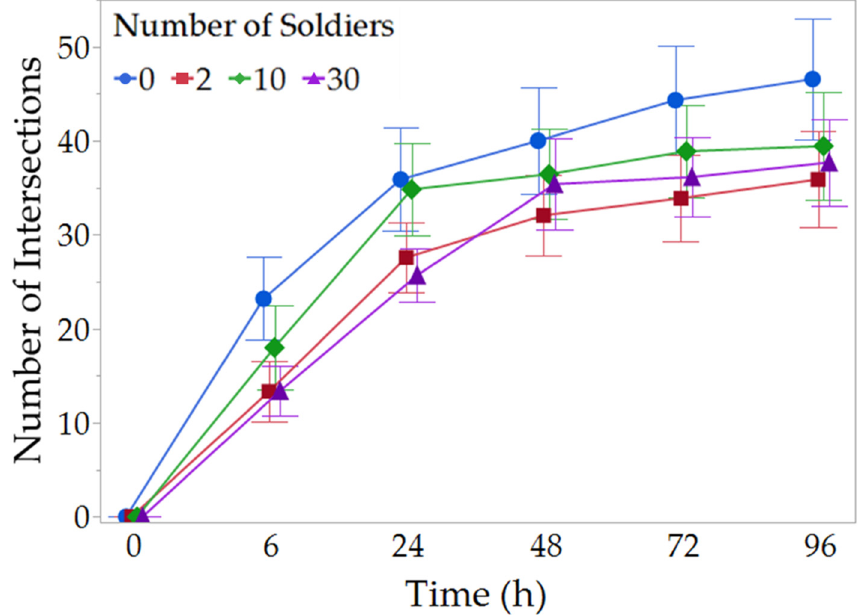
Figure 3. Changes in number of tunnel intersections during exploratory foraging phase. Tunnels were constructed by groups of 100 foraging workers with different numbers of soldiers. Data shown are means ± SEM. No significant difference was detected among treatments at any time point (NB-GLMM, p > 0.05, n = 16).